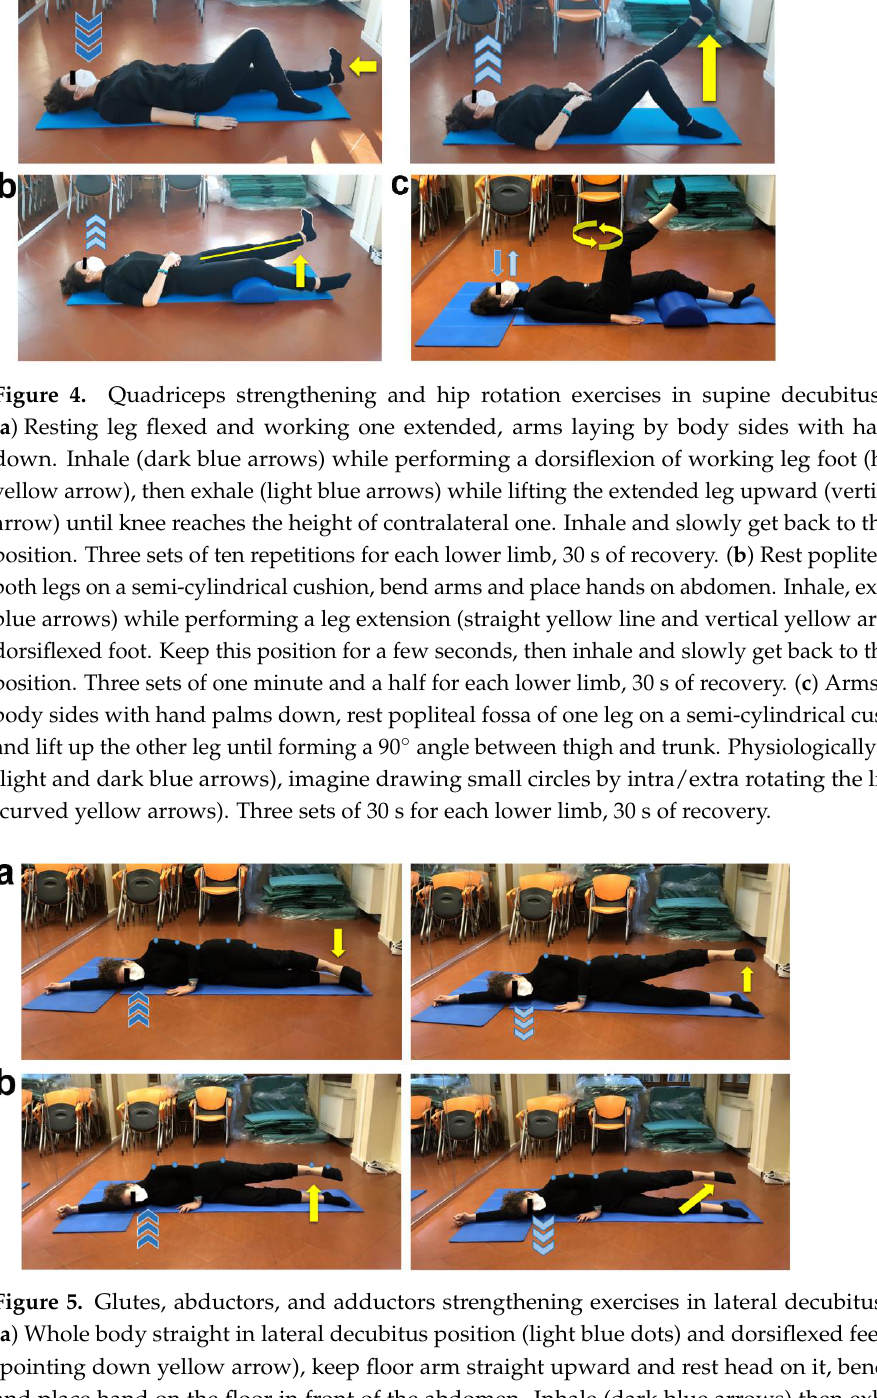
Figure 6. Lower limb extension and flexion in quadruped position. ( a ) Quadruped position, neutral spine attitude (light blue dots), place both elbows shoulder-width apart on the floor, keep the ground knee right under the homolateral hip and straighten backward the contralateral lower limb with dorsiflexed foot (pointing down yellow arrow). Inhale (dark blue arrows), then exhale (light blue arrows) while extending the straight lower limb on sagittal plane (pointing up yellow arrow). Three sets of 45 s for each lower limb, 15 s of recovery. ( b ) Repeat the previously described exercise performing a flexion of the other lower limb on sagittal plane by bringing the knee closer to chest with dorsiflexed homolateral foot (short yellow arrow), and then extend the same lower limb back- ward (diagonal yellow arrow). Three sets of 45 s for each lower limb, 15 s of recovery.